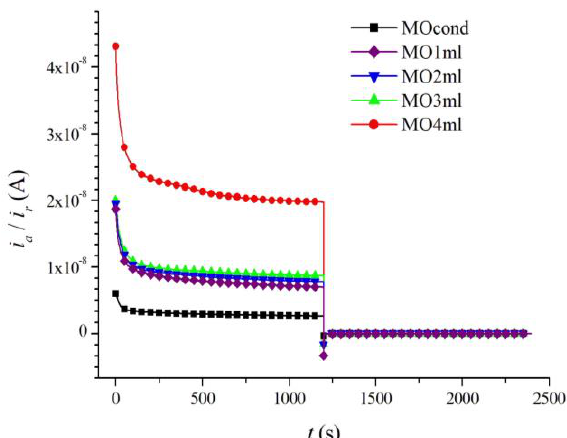
Figure 6. The variation of the absorption and the resorption currents against time ( U 0 = 200 V and T = 24 °C).